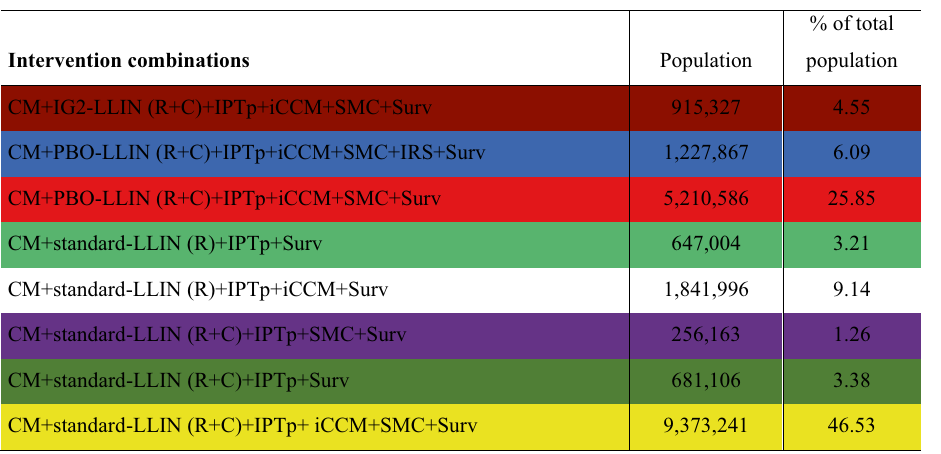
Table 2. Population targeted by the 8 intervention